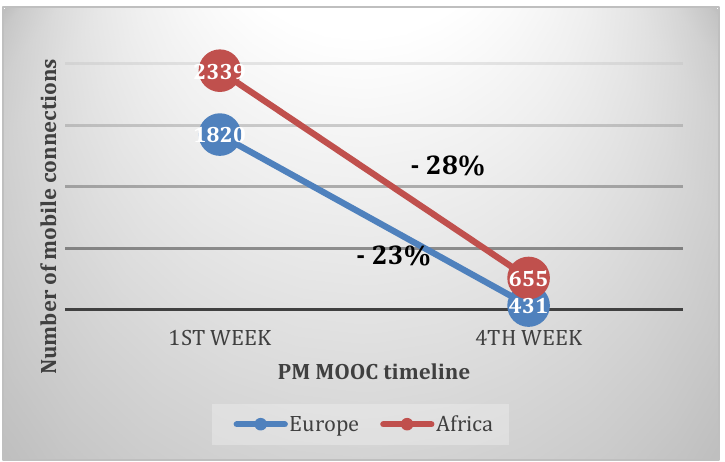
Figure 7. Number of mobile connections between the first and fourth week of the 11th edition of the French PM MOOC (March–April,